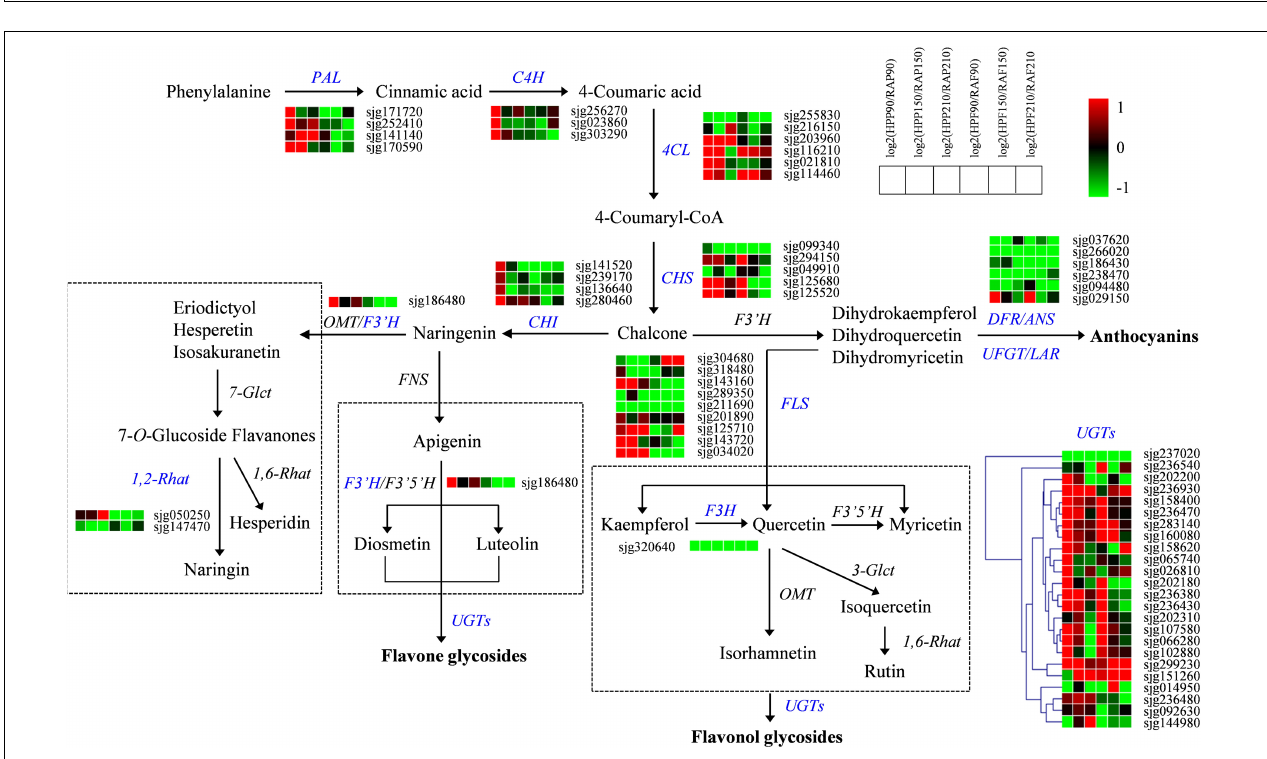
FIGURE 5 | Expression profiles of genes from the flavonoid biosynthesis pathway in the peel and flesh of kumquat fruits. The color scale from green (low) to red (high) represents the values of the log2 ratio (HP/RA) at 90, 150, and 210 DAF. The differentially expressed genes are highlighted in blue. PAL, phenylalanine ammonia-lyase; C4H, trans-cinnamate 4-monooxygenase; 4CL, 4-coumarate-CoA ligase; CHS, chalcone synthase; CHI, chalcone isomerase; 1,2-Rhat, 1,2-rhamnosyltransferase; F3 (cid:48) H, flavonoid 3 (cid:48) -monooxygenase; F3H, flavanone 3-dioxygenase; FLS, flavonol synthase; DFR, dihydroflavonol 4-reductase; ANS, anthocyanidin synthase; LAR, leucocyanidin reductase; UFGT, UDP-glucose flavonoid 3-O-glucosyltransferase; UGT, UDP-glycosyltransferase; 1,6-Rhat, 1,6-rhamnosyltransferase; 7-Glct, flavanone 7-O-glucosyltransferase; 3-Glct, anthocyanidin 3-O-glucosyltransferase; FNS, flavone synthase; F3 (cid:48) 5 (cid:48) H, flavanoid 3 (cid:48) ,5 (cid:48) -hydroxylase; OMT, O-methyltransferase.